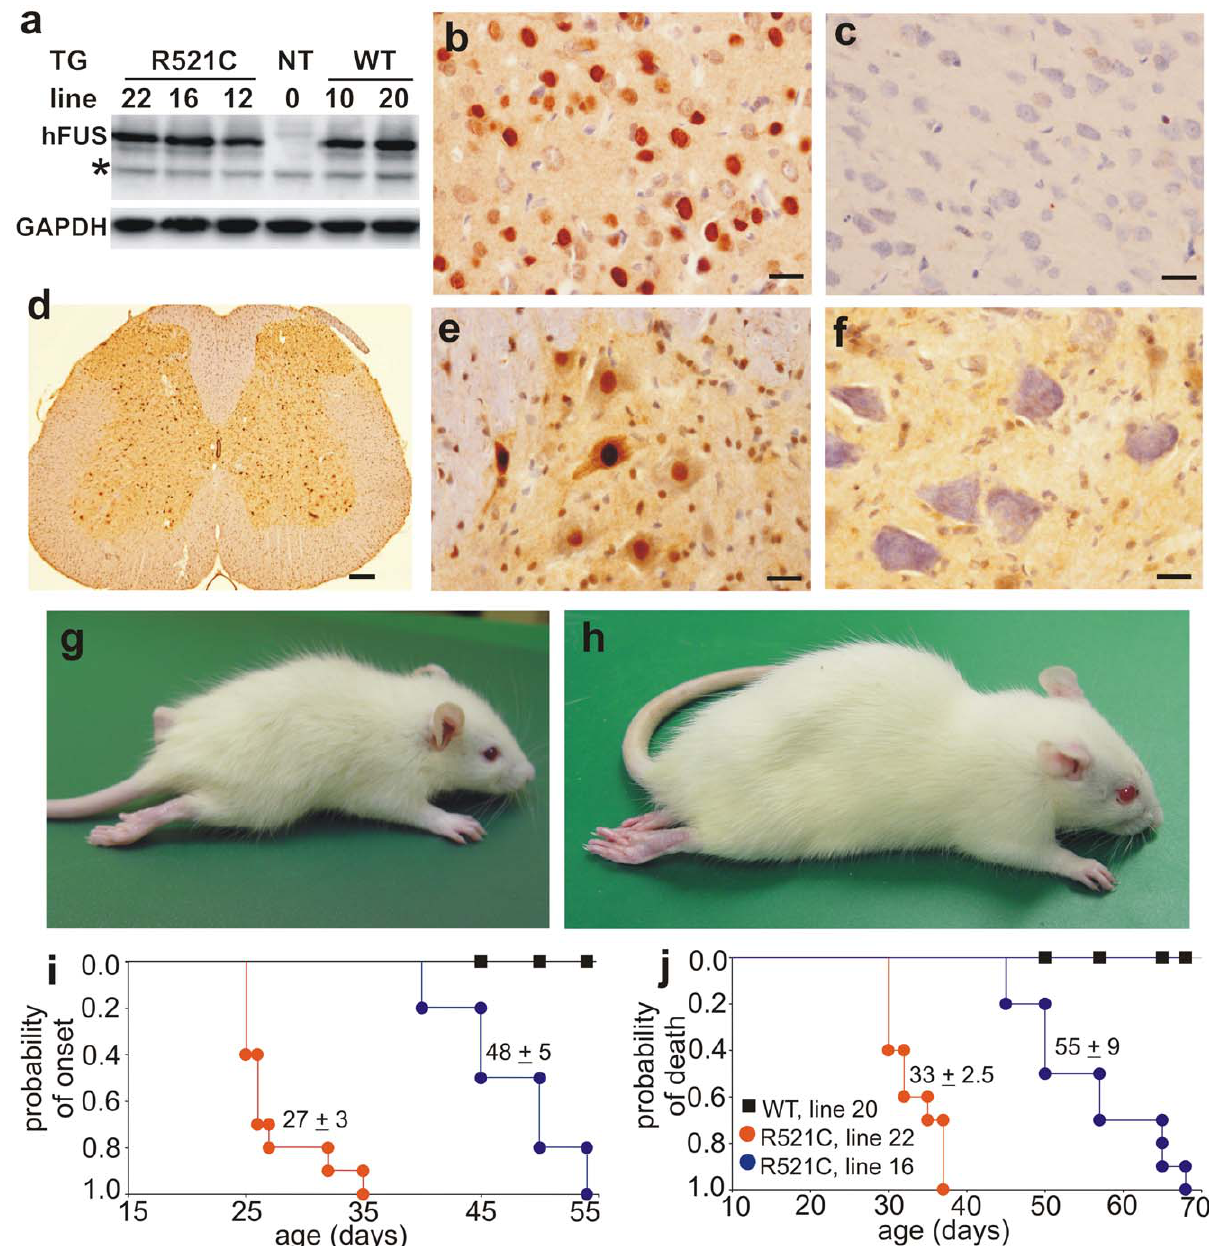
Figure 1. Progressive paralysis in transgenic rats overexpressing a mutant human FUS. (A) Immunoblotting showed expression of human FUS in normal (WT) and mutant (R521) fus transgenic rats, but not in nontransgenic controls (NT). Each lane was loaded with 30 m g of total protein in the lysates of spinal cord. The blotting membrane was probed with an antibody to human FUS (made in-house) and then with an antibody against GAPDH after stripping. The number of transgenic lines corresponds to the number of FUS transgene copies. * indicates a non-specific band. (B–F) Immunohistochemistry detected expression of human FUS in the cortex (B) and spinal cord (D, E) of FUS transgenic rats (line 16), but not in tissues of nontransgenic littermates (C, cortex; F, spinal cord). Expression of human FUS in lumbar spinal cord profiled at a low magnification (D). Human FUS was diffusely located in the cytoplasm of motor neurons in the ventral horn (E). Scale bars: B–C and E–F: 20 m m; D, 100 m m. (G, H) Representative photographs of male transgenic rats of line 22 (G, 30 days of age) and line 16 (H, 60 days of age) at paralysis stages. (I, J) Graphs show the probability of disease onset (I) and survival (J) in FUS transgenic rats. Disease onset was defined as an unrecoverable reduction in the grip strength of fore or hind paws. Rats were euthanized and counted as dead when two or more legs were paralyzed or body weight was reduced by 30%. All FUS transgenic rats carried the CAG-tTA transgene. Breeding female rats were given Dox in their drinking water (50 m g/ml) until delivery. Each group contained 13 to 16 rats. doi:10.1371/journal.pgen.1002011.g001 (Figure 5D–5F) and spinal cord (Figure 5J–5L) of mutant FUS 5A–5C and 5G–5I). In the normal FUS transgenic rats, transgenic rats at paralysis stages, but was not detected in the ubiquitin aggregates were observed only when neuronal loss tissues of age-matched normal FUS transgenic rats (Figure was detected at advanced ages (Figure 4), suggesting that